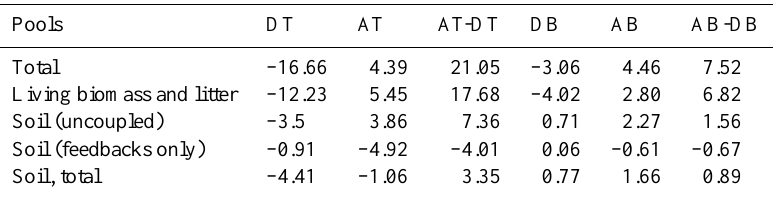
Table 2. Terrestrial carbon storage anomalies in kg/m 2 , averaged over the areas of changed forest cover and the final 10years of each experiment (ice sheets not